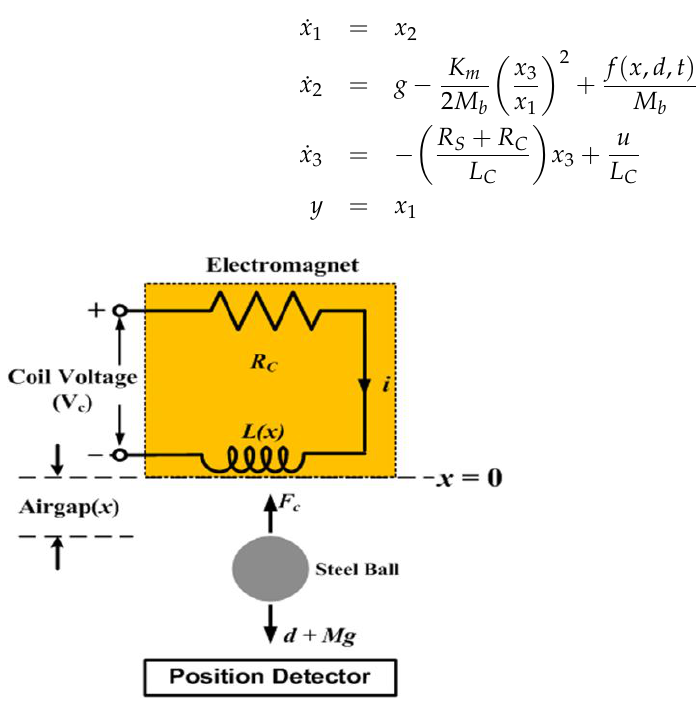
Figure 1. Schematic of voltage-controlled MLS.